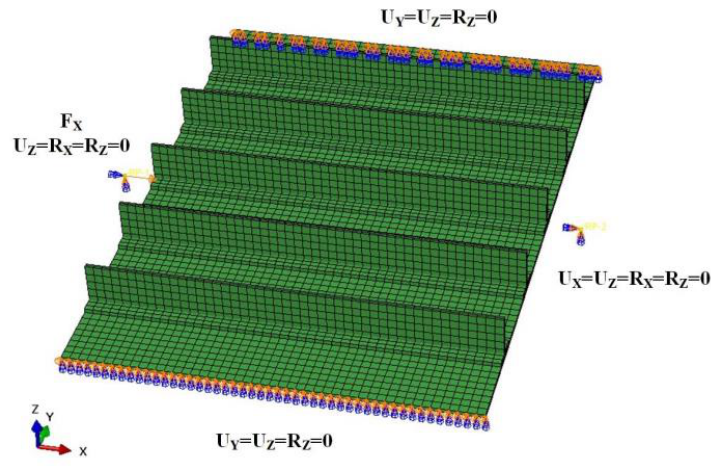
Figure 10. Boundary conditions of the macro-scale stiffened panel.